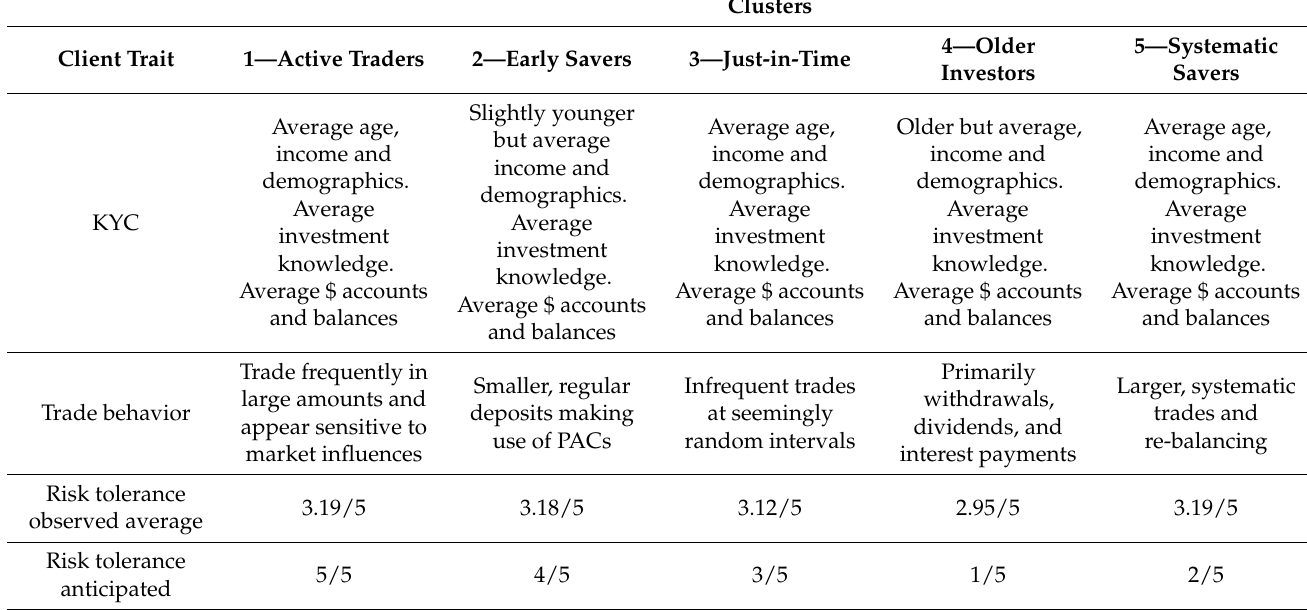
Table 6. KYC demographics and trading behaviours compared to expected risk tolerance and anticipated risk tolerance for each cluster. Risk tolerances are calculated on a scale of 1 to 5, where 1 is a low or preservation risk tolerance and 5 is high or aggressive.